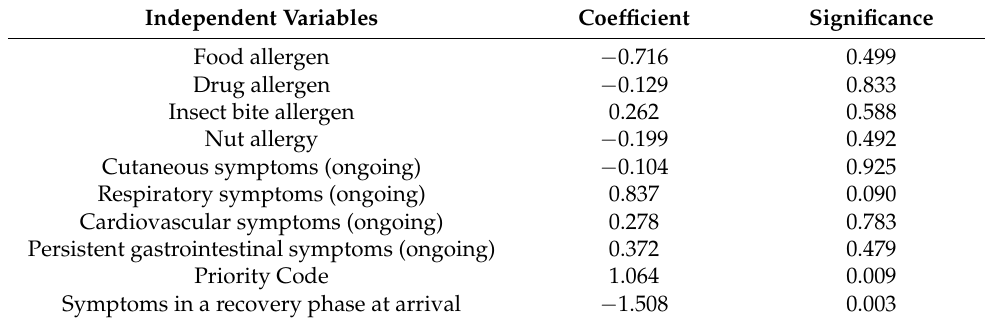
Table 6. Binary logistic regression with diagnosis of anaphylaxis as dependent variable and items list in columns 1 as independent variables. Coefficient points to direction of the